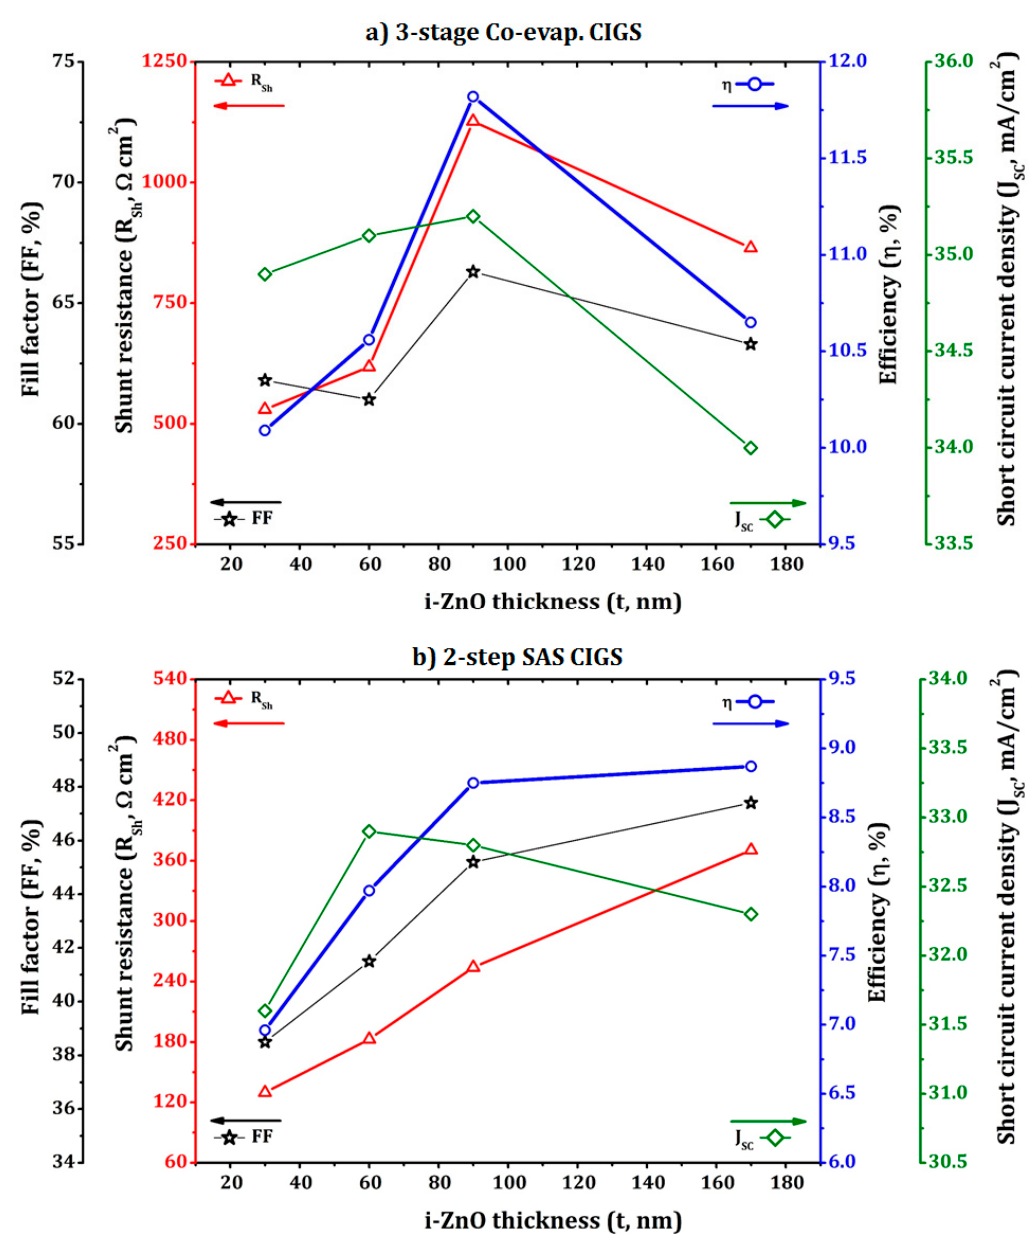
Figure 12. Change of the CIGS device performance parameters, i.e., fill factor (FF), shunt resistance (R SH ), efficiency ( η ), and short circuit current density (J SC ), with the i-ZnO thickness for ( a ) three-stage co-evaporated CIGS and ( b ) two-step SAS CIGS absorbers.